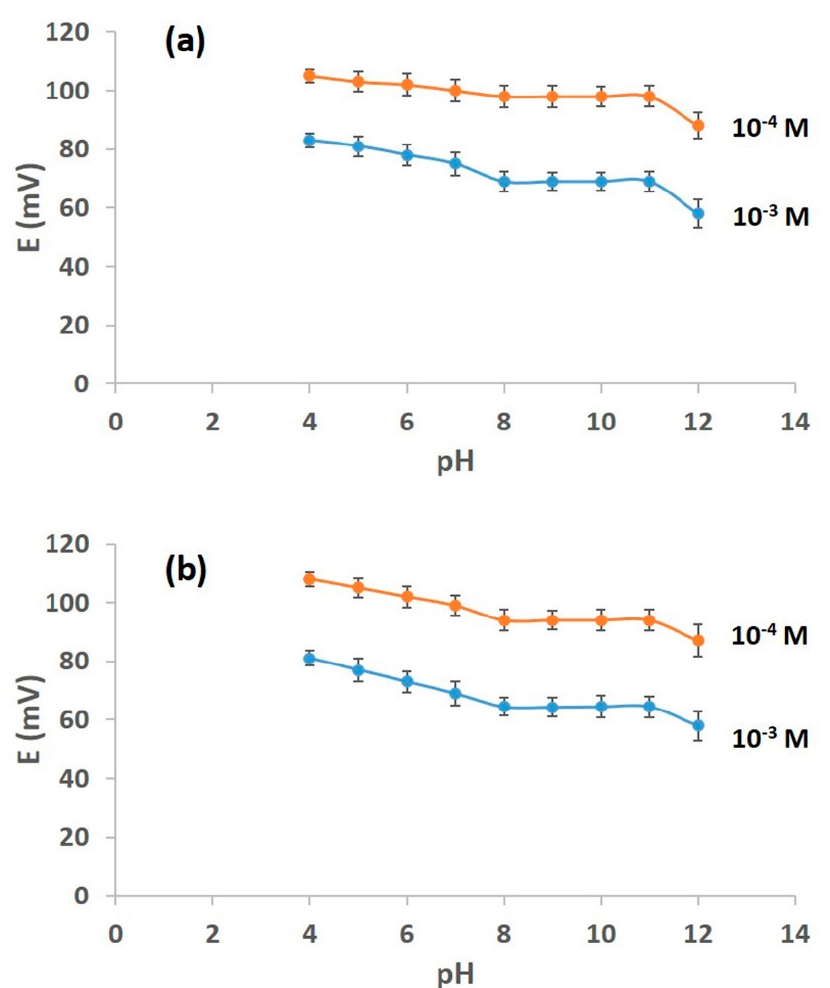
Figure 4. Effect of pH on the potential response of ( a ) PVC membrane electrode and ( b ) GC electrode. The calibration plots were also studied at three temperature levels of 25 ◦ C, 30 ◦ C, and 40 ◦ C, to study the effect of temperature on the electrodes’ potential. It was observed that the constructed calibration graphs were almost similar. The LOD and slope showed insignificant variation, indicating realistic thermal stability of the fabricated membrane electrodes up to 40 ◦ C. The results regarding the thermal stability of electrodes at three temperature levels are tabulated in Table